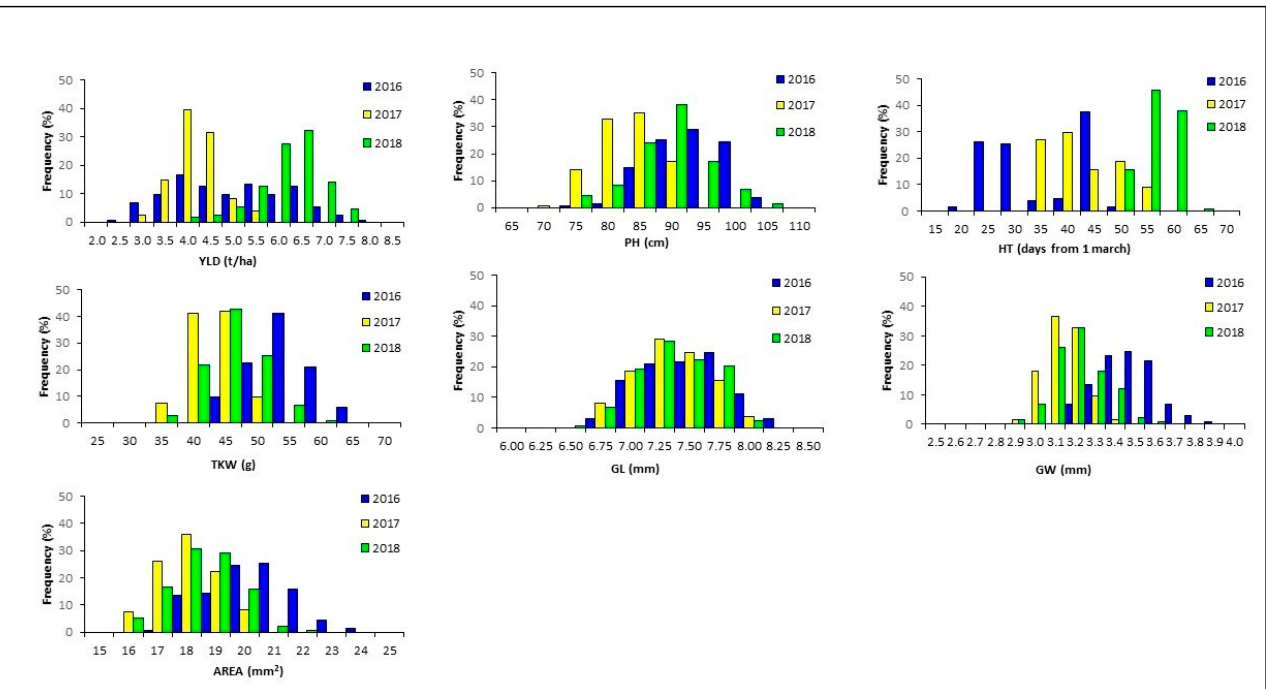
Figure 1. Frequency distribution of grain yield (YLD), plant height (PH), heading time (HT), thousand kernel weight (TKW), grain length (GL), grain width (GW), grain area (AREA) in the Liberdur x Anco Marzio RILs mapping population evaluated at Valenzano (Bari, Italy) for three years.